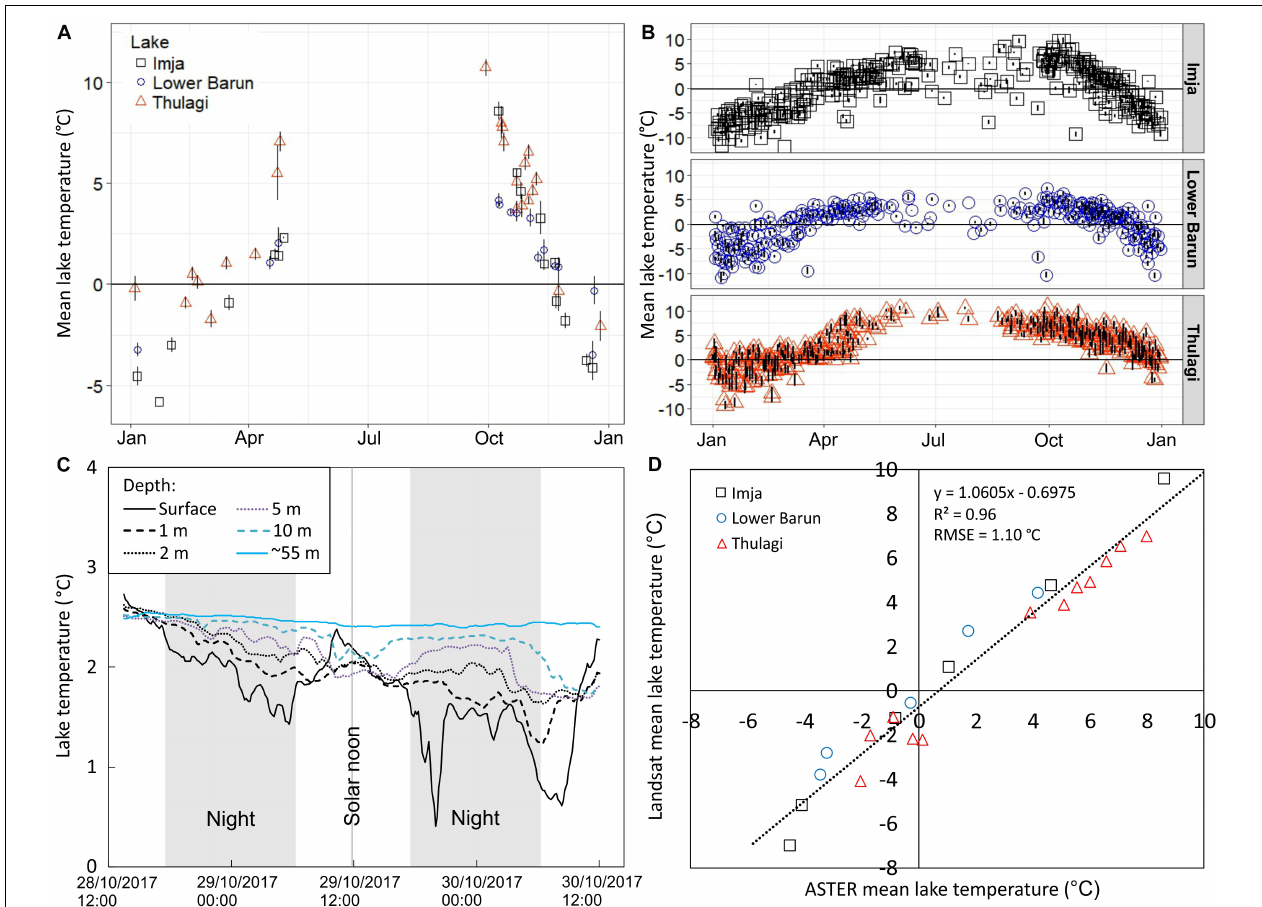
FIGURE 4 | (A) Mean lake temperature derived from ASTER L2 Surface Kinetic Temperature data ( n = 17, 14 and 21, for Imja, Lower Barun and Thulagi, respectively). Error bars indicate one standard deviation. (B) Mean lake temperature from Landsat thermal data ( n = 300, 291 and 338, for Imja, Lower Barun and Thulagi, respectively). (C) Vertical temperature profile at Thulagi Lake (28–30 October 2017). (D) Comparison of coincident ASTER- and Landsat-derived lake temperatures ( n =